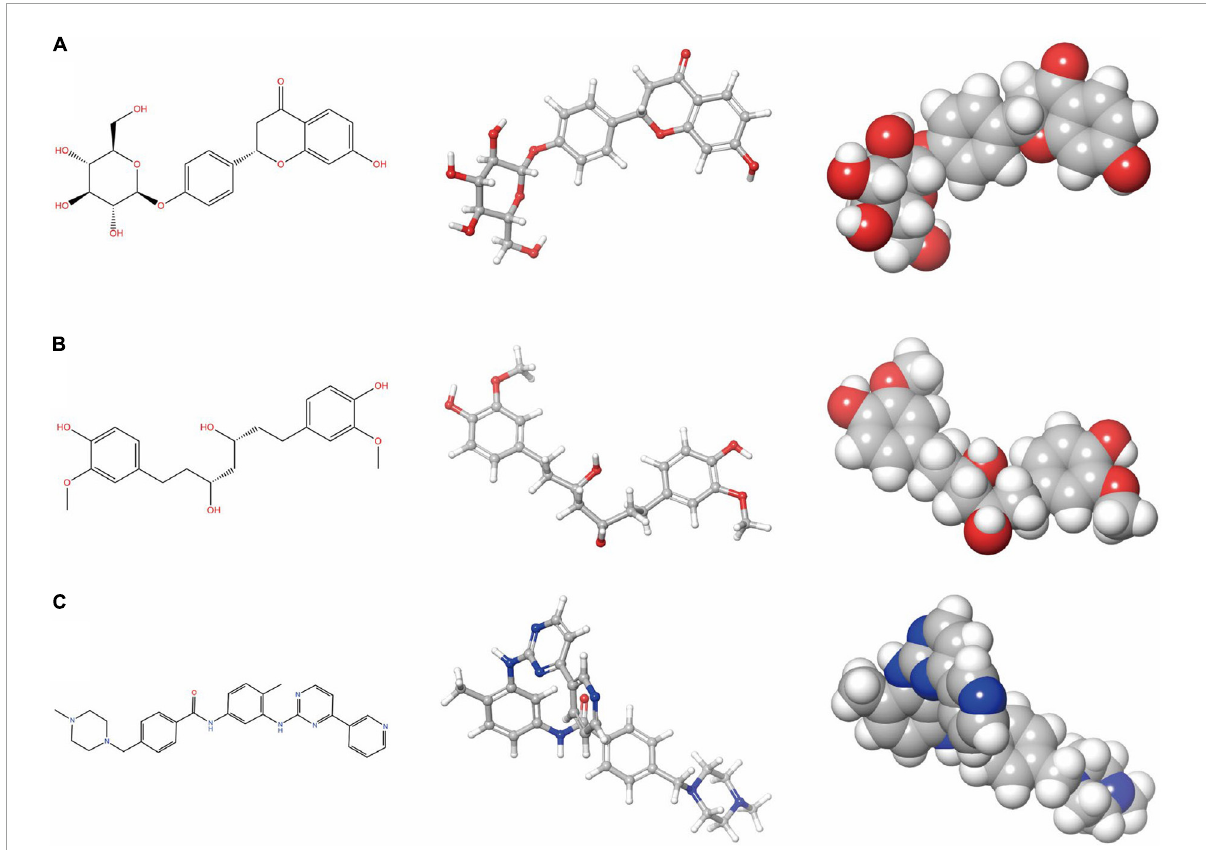
FIGURE2 Schrodinger selected the 2D and 3D structures of Imatinib and novel compounds from virtual screening. (A) ZINC000008829785; (B) ZINC000013377891; and (C)